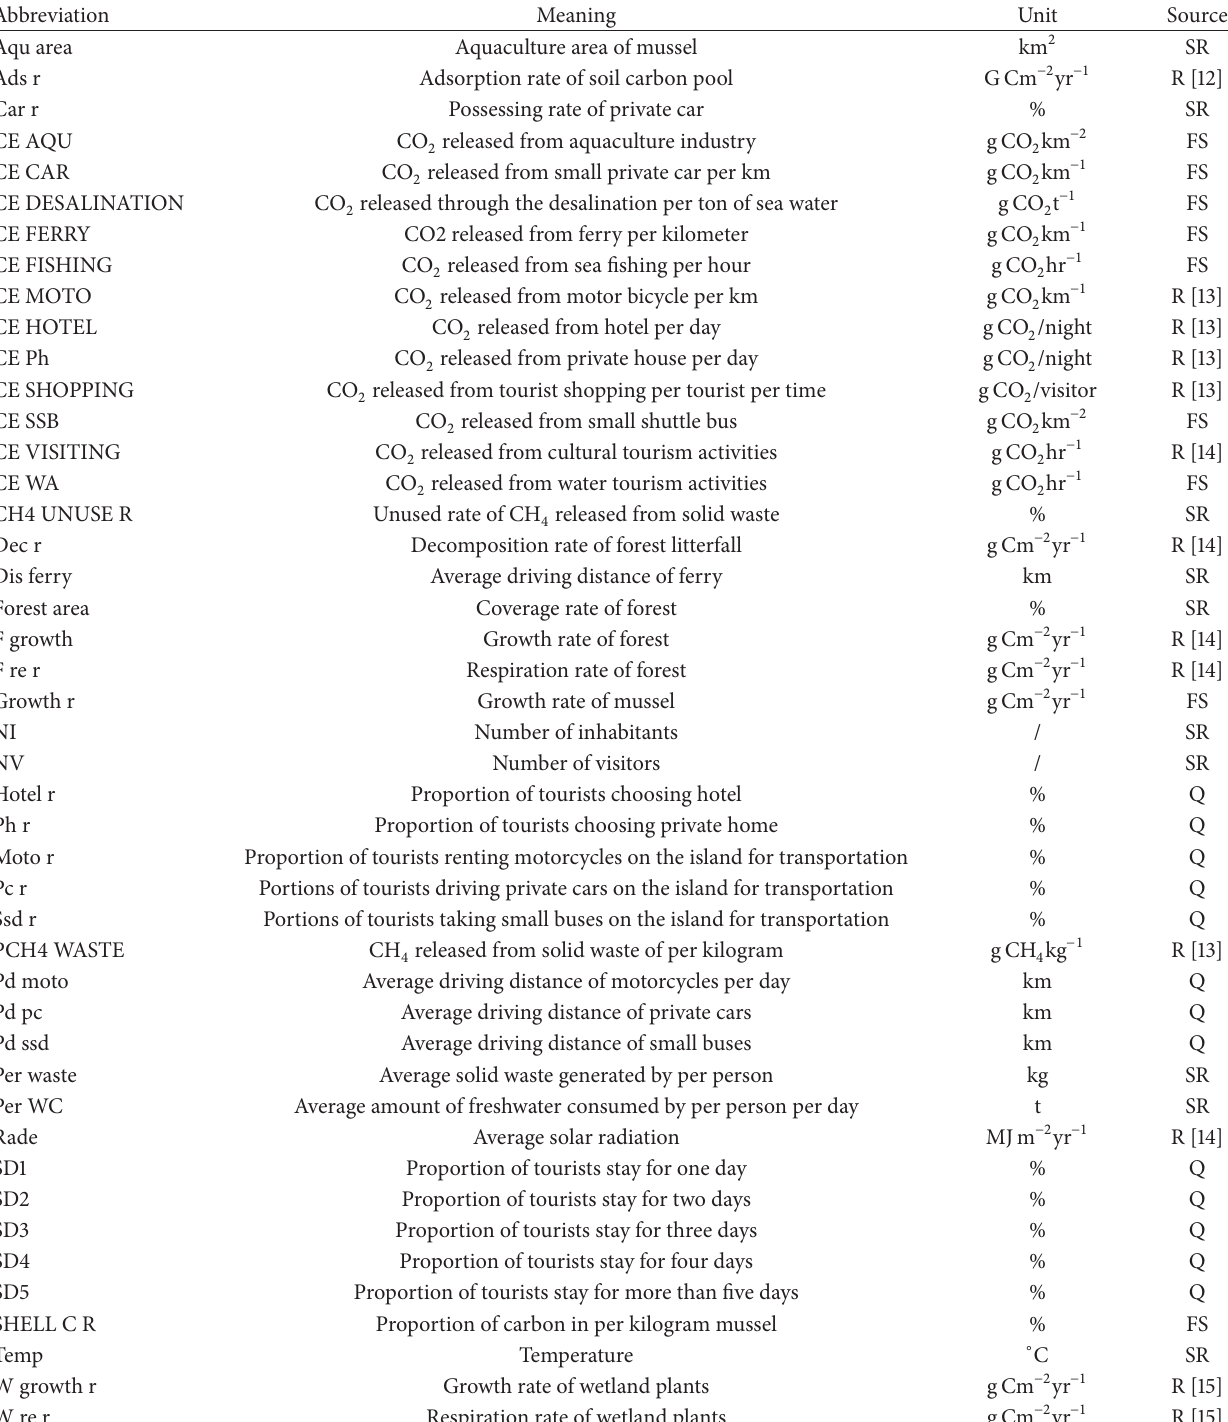
Table 5: Summary of the parameter symbols used in the model and the resources of the data. (SR = statistic report; FS = field survey; Q = questionnaire; R =